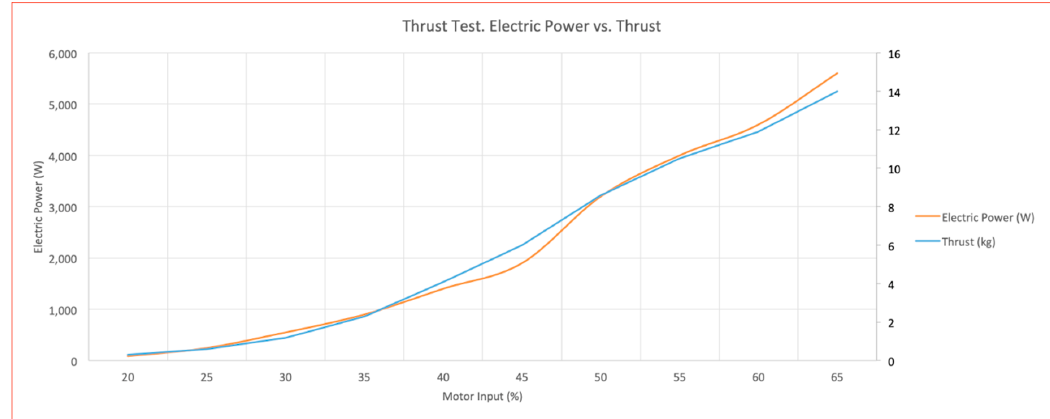
Figure 23. Electric ALO thrust test. Electric power vs. thrust.